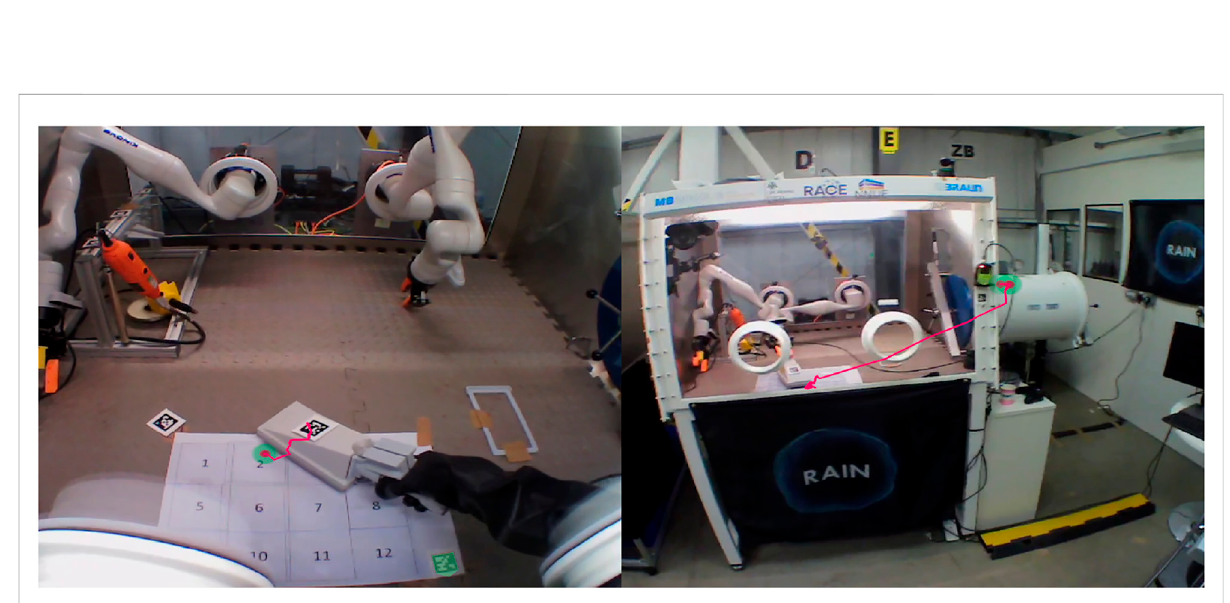
FIGURE 9 Example of fi xations (green dot) and gaze patterns (purple lines) while performing radiation surveying using manual operation (left) and tele- manipulation